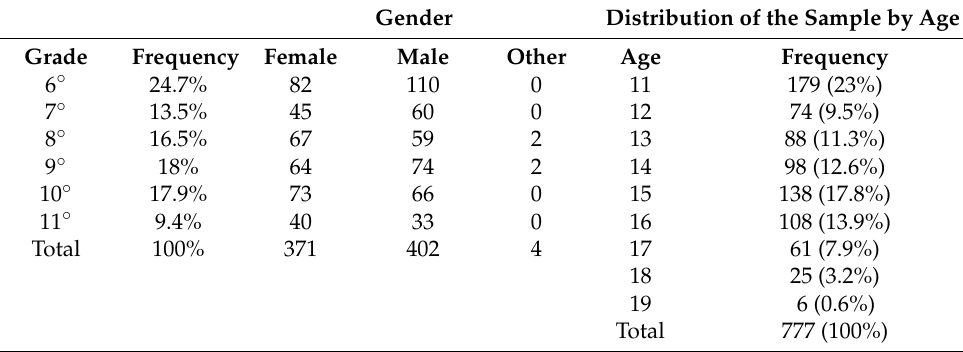
Table 2. Distribution of the sample by grade, gender, and age. Gender Distribution of the Sample by